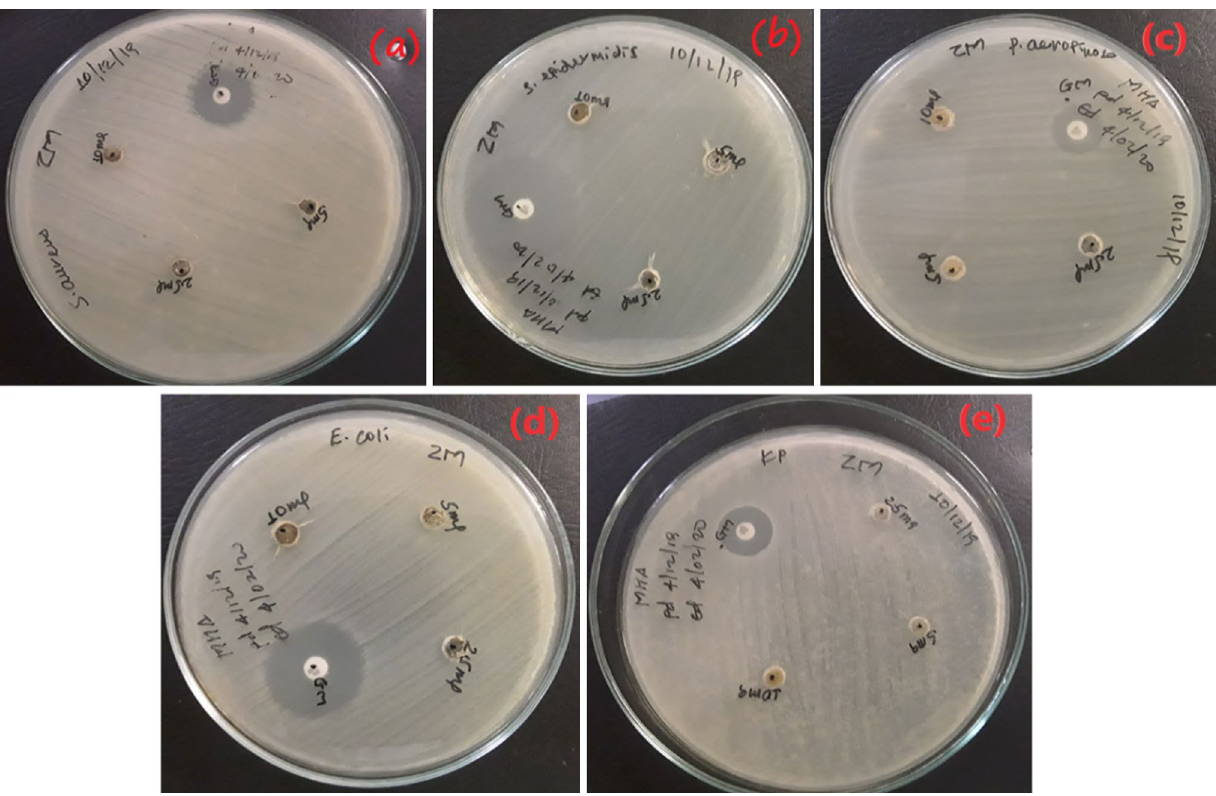
Fig. 12 Antimicrobial activities of ZnO NPs against a Staphylococcus aureus , b Staphylococcus epidermidis , c Pseudomonas aeruginosa , d Escherichia coli and e Klebsiella